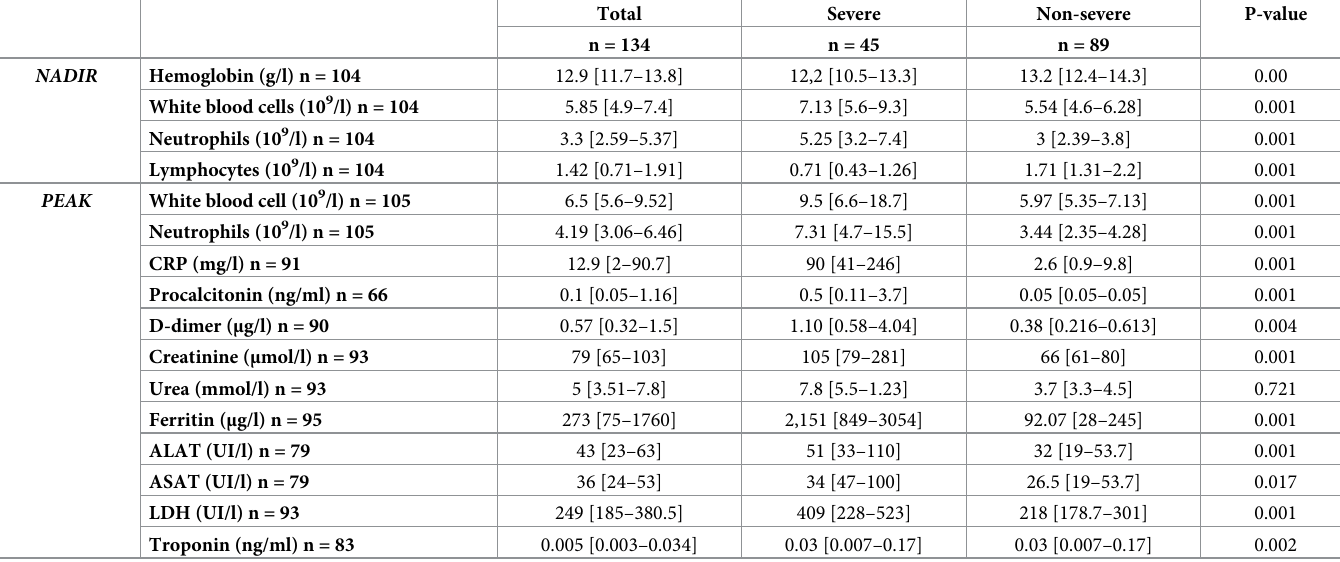
Table 3. Blood profile during inpatient stay (nadir and peak of laboratory